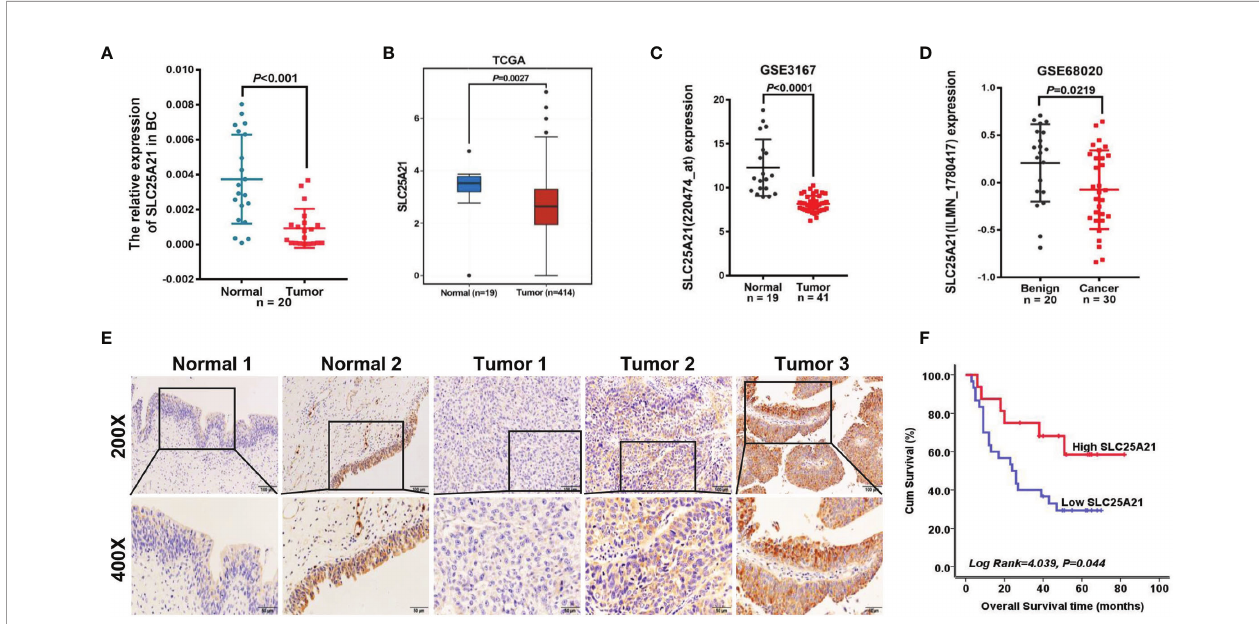
FIGURE 1 | SLC25A21 is downregulated in BCa and negatively associated with poor prognosis in BCa patients. (A) Expression levels of SLC25A21 mRNA in BCa and pair-matched noncancerous tissue samples. (B – D) Analysis of SLC25A21 expression in BCa compared with noncancerous tissue according to RNA-seq in TCGA database and BCa microarray pro fi le (GSE3167 and GSE68020) (E) Expression analysis of SLC25A21 protein in BCa and normal bladder mucosa tissues by IHC. Scale bars, 100 m m (200x) or 50 m m (400x). (F) Correlation between SLC25A21 protein expression and overall survival in BCa patients (log-rank P